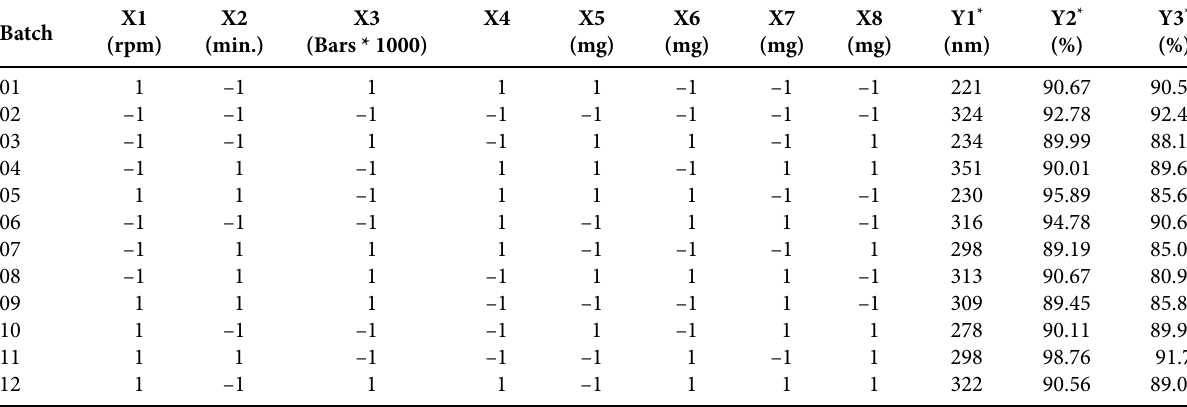
Table 5. Plackett–Burman experimental design matrix with observed values of response variables.